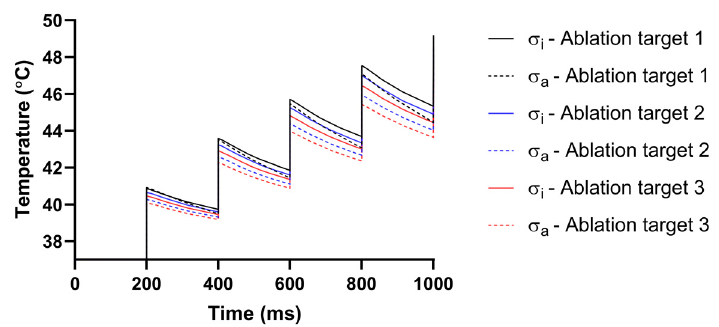
Figure 19. Under the condition of the same PFA parameters (see “Boundary Conditions”) and AC and the corresponding IC from the fourth electrical conductivity group with the highest anisotropy ratio, the curve of maximum temperature is generated in the myocardium at three ablation